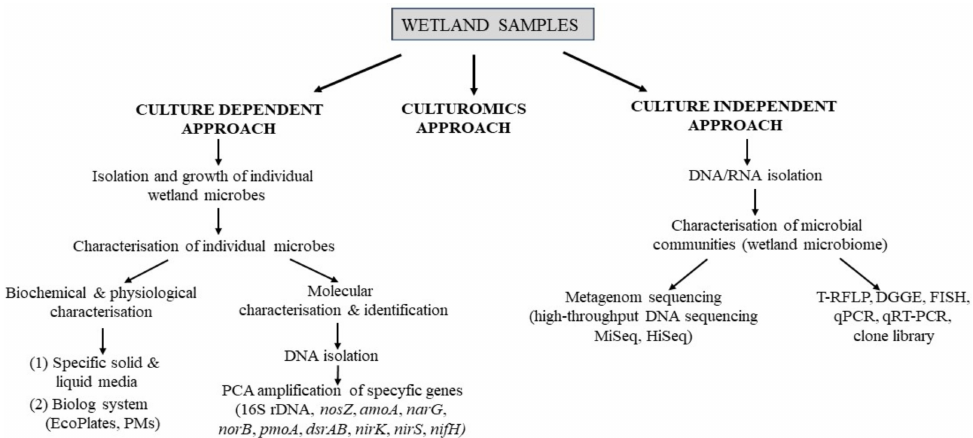
Figure 3. Flowchart of the methods used to characterise the functional and structural diversity of wetland microbial species and